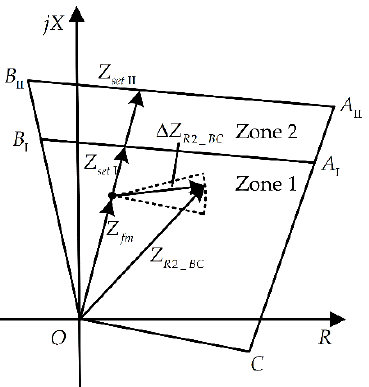
Figure 6. The measured impedance of R2 when the magnitudes of fault currents flowing through both ends of line mn differ greatly.